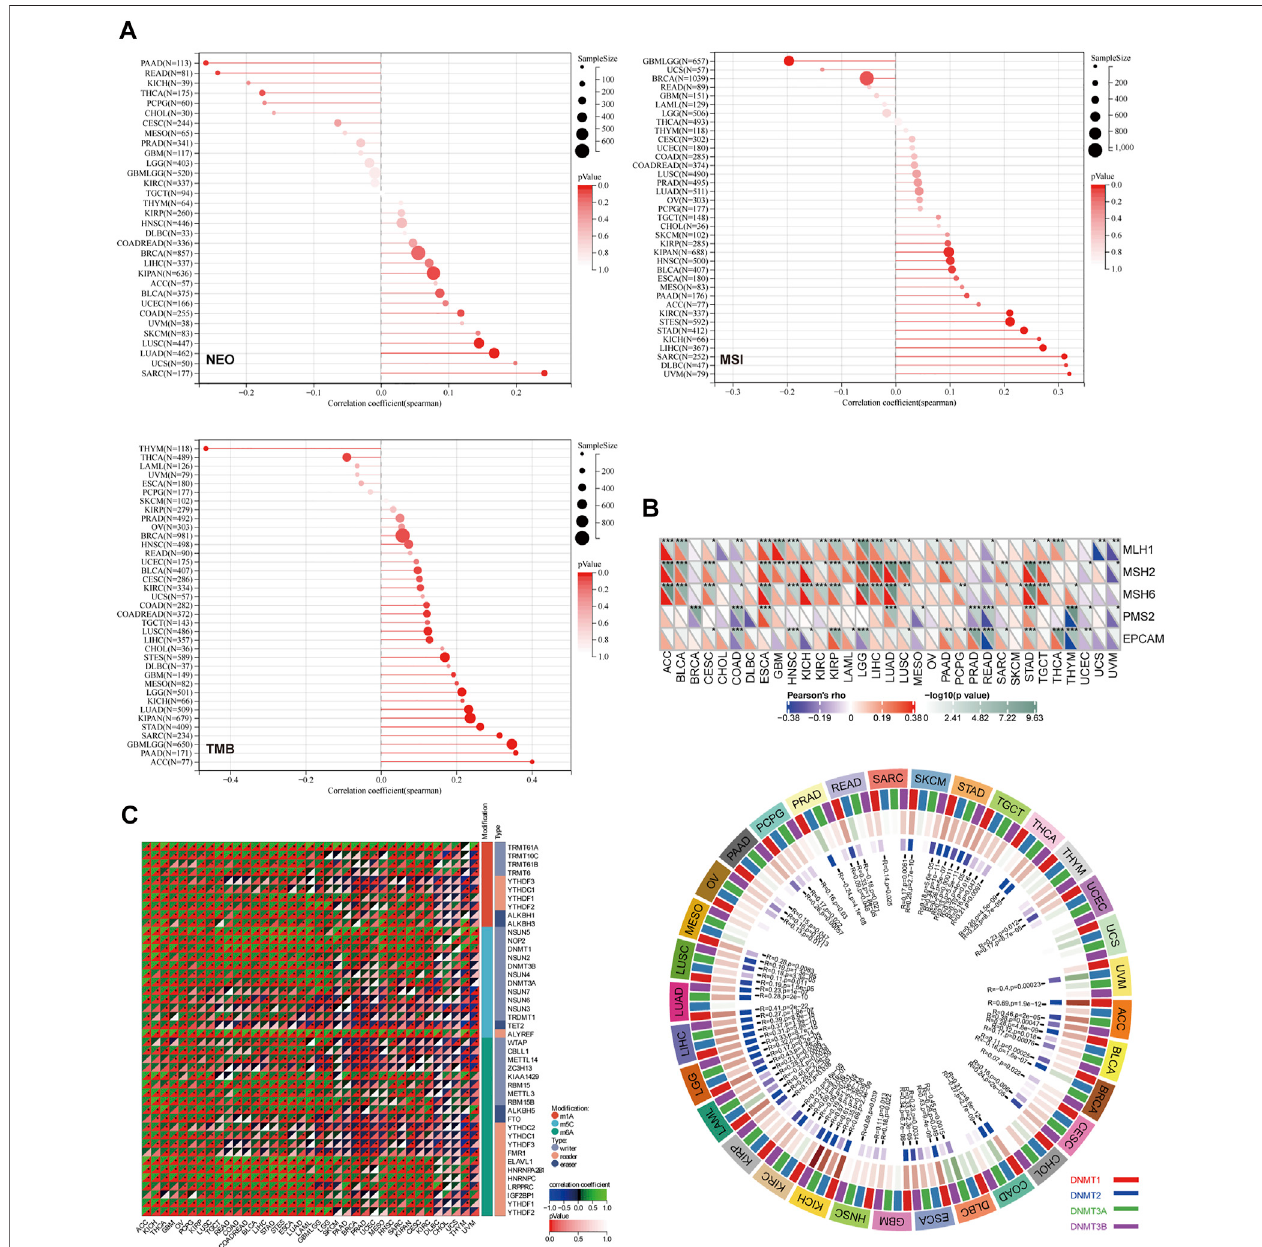
FIGURE 5 | The correlation analysis between Reptin and NEO, TMB, MSI, MMRs, methyltransferase, and RNA modi fi cation genes. (A) The correlation between ReptinandNEO,TMB, MSIinpan-cancer. (B) ThecorrelationbetweenReptinandMMRs,methyltransferase. (C) Thecorrelation betweenReptinandRNAmodi fi cation genes. * p < 0.05, ** p < 0.01, *** p <